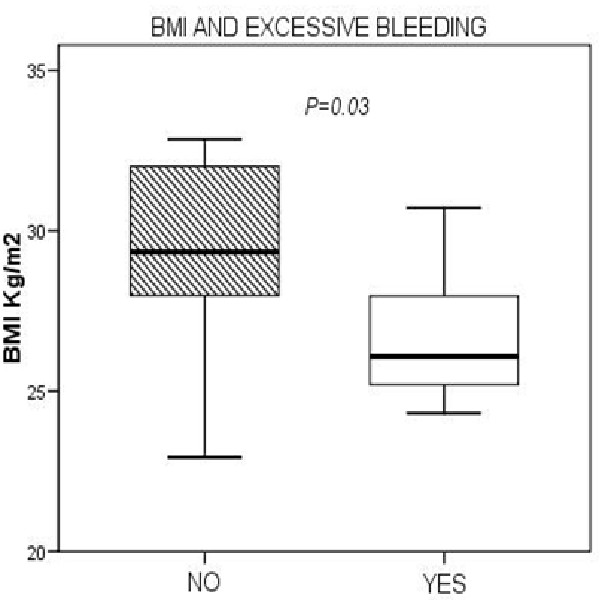
Horizontal line represents the median, box encompasses the 25th–75th percentile, and error bars encompass the 10th–90th percentile.